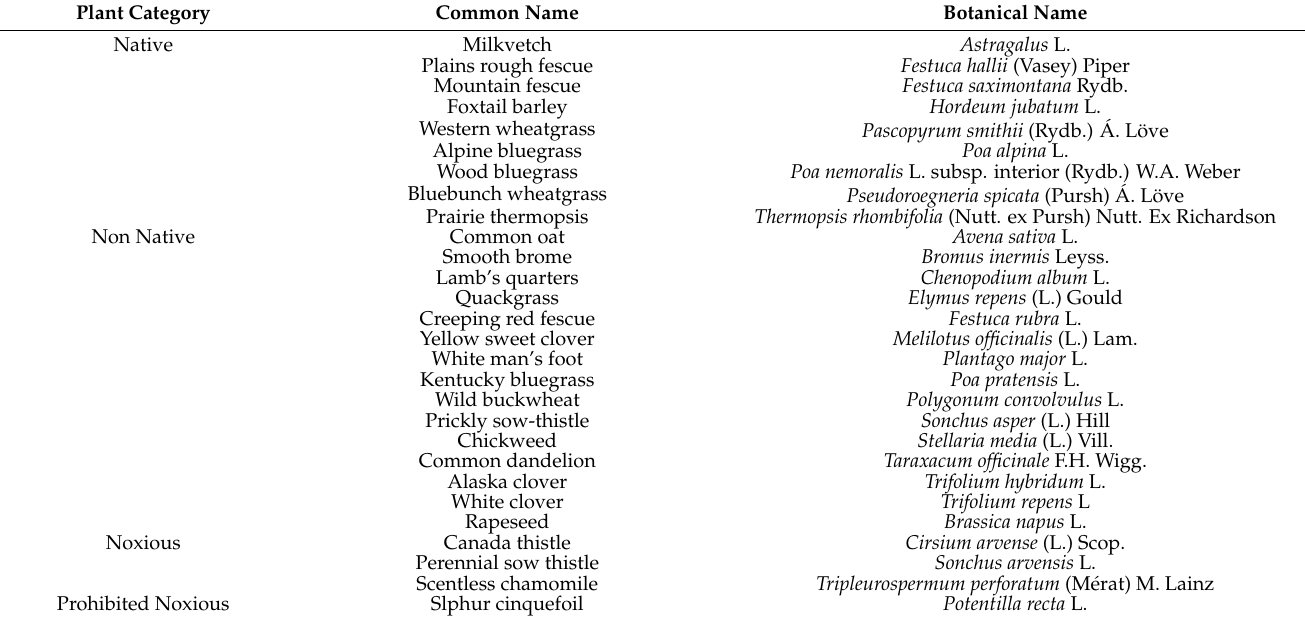
Table A1. List of species found in the study